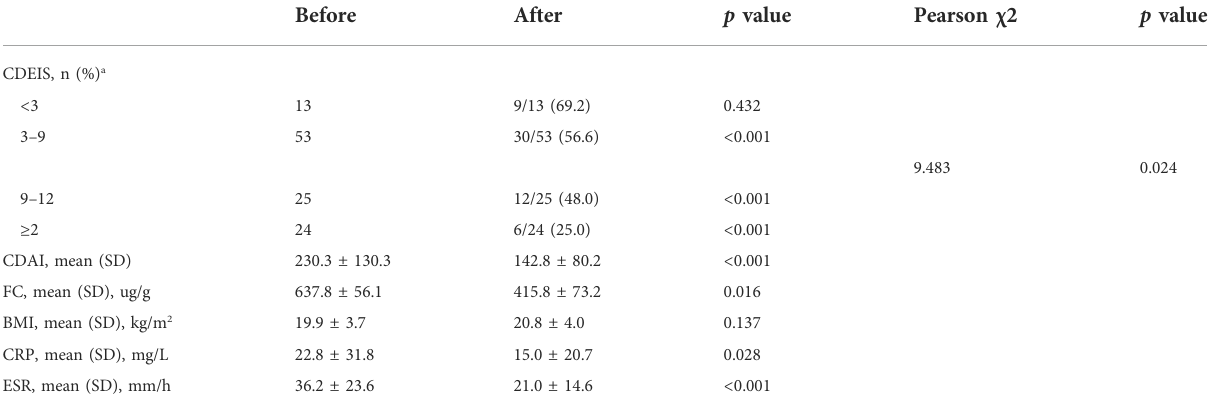
TABLE 2 Patient demographics of before and after adalimumab treatment. Before